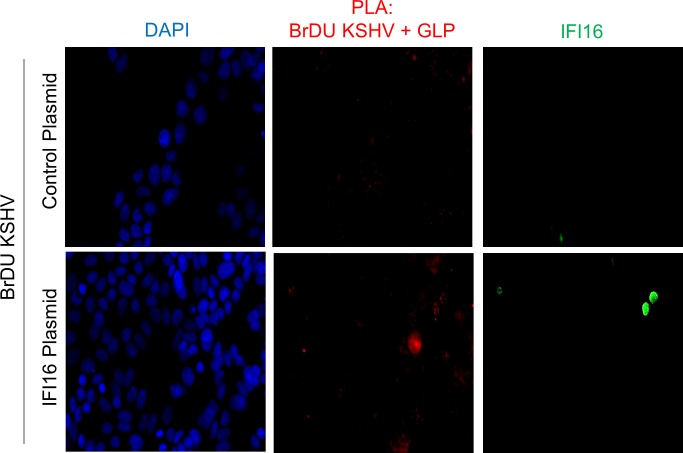
Uncropped source PLA data for Figure 7C.A larger field containing multiple cells are shown.